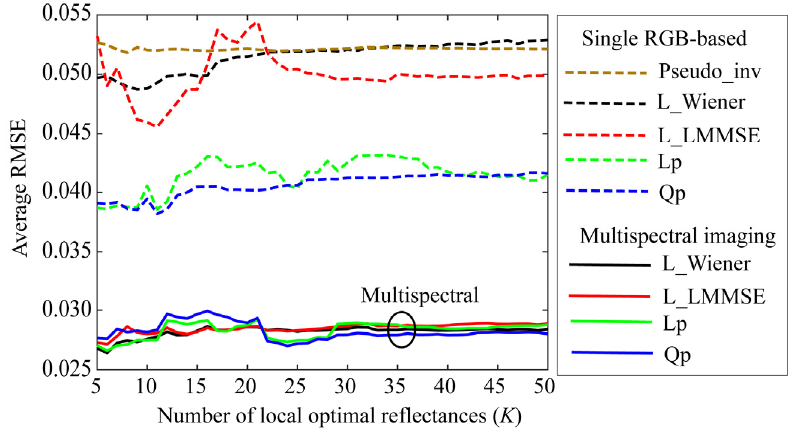
Figure 14. Reflectance estimation results for single RGB-based spectral estimation, where RGB images for 24 color checkers were acquired using iPhone 6s. Pseudo_inv represents the average RMSEs yielded by the pseudo-inverse method using the weights as a function of the number of the selected local optimal reflectances. L_Wiener, L_MMSE, Lp, and Qp denote the proposed methods using the local optimal dataset without using the weights, respectively. Four spectral curves at bottom of the figure show the average RMSEs in Figure 7 reconstructed using a multispectral imaging system for comparison.